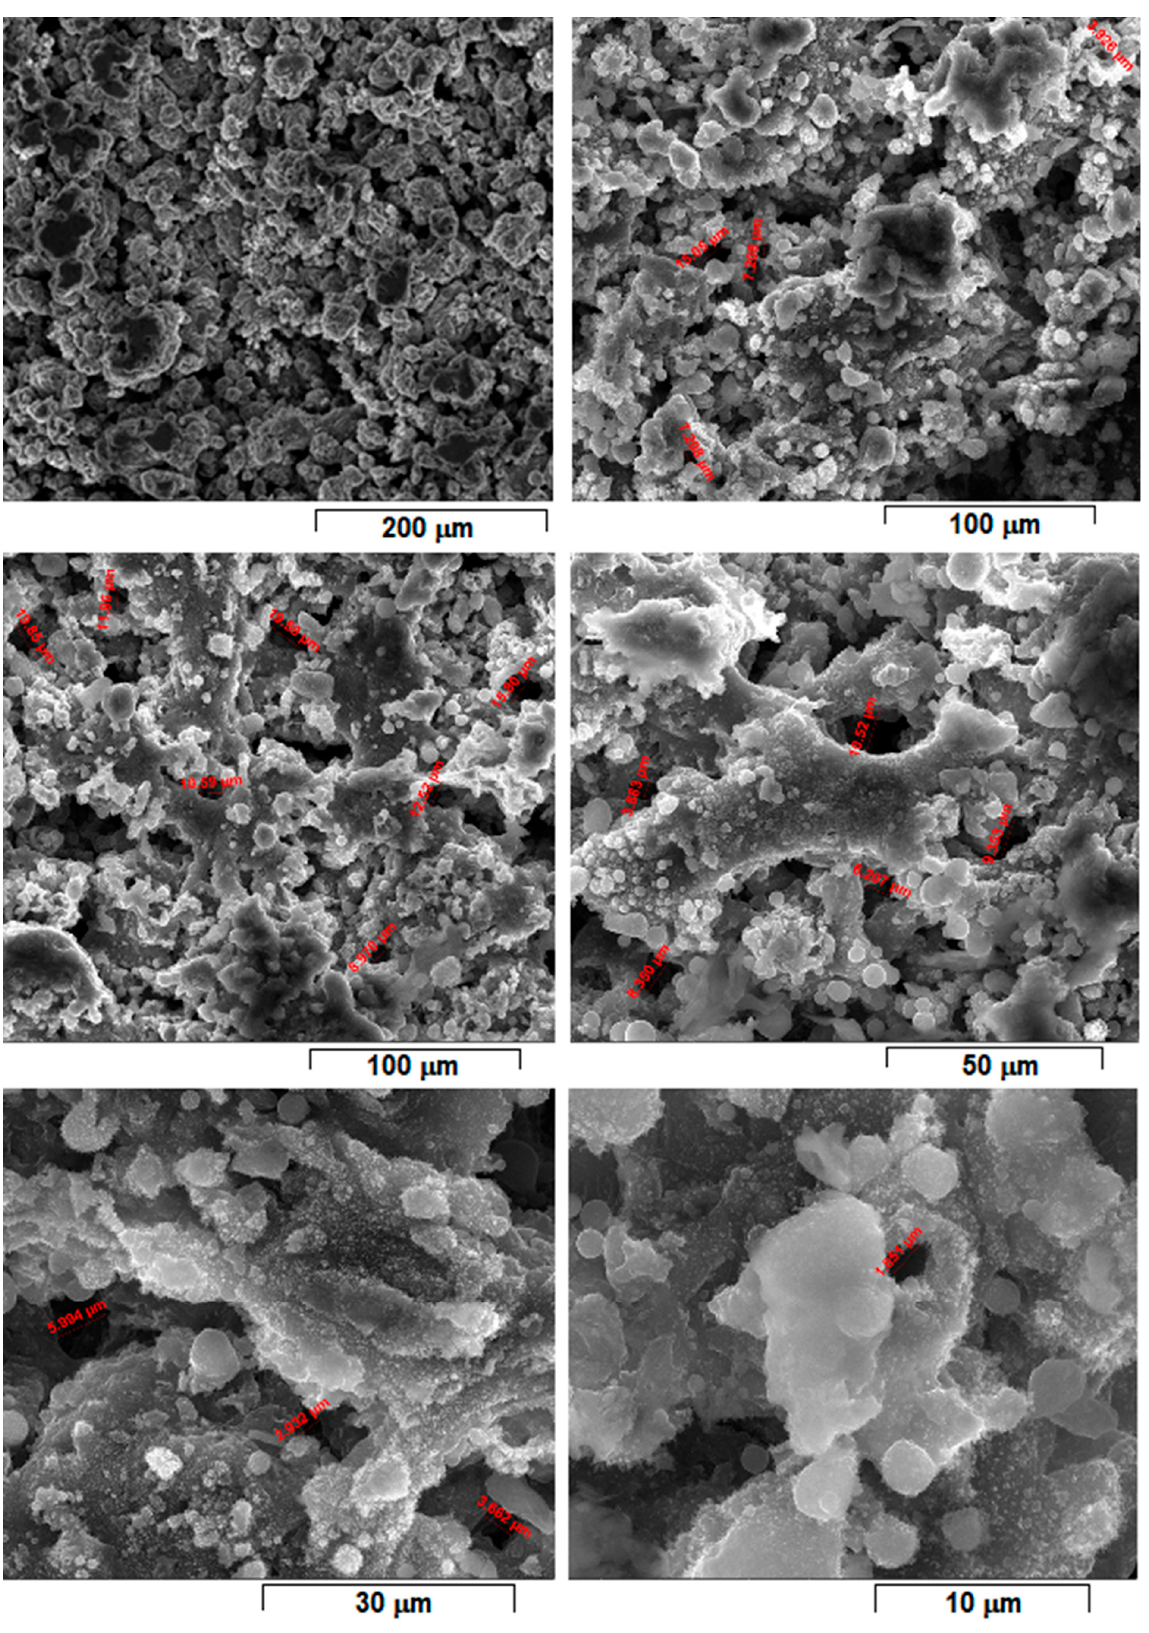
Figure 9. SEM-SE images of L-PBF sample obtained with laser power 45 W; scanning speed 600 mm/s; layer height 30 μ m applied parameters and calculated laser energy density 100 J/mm 3 .